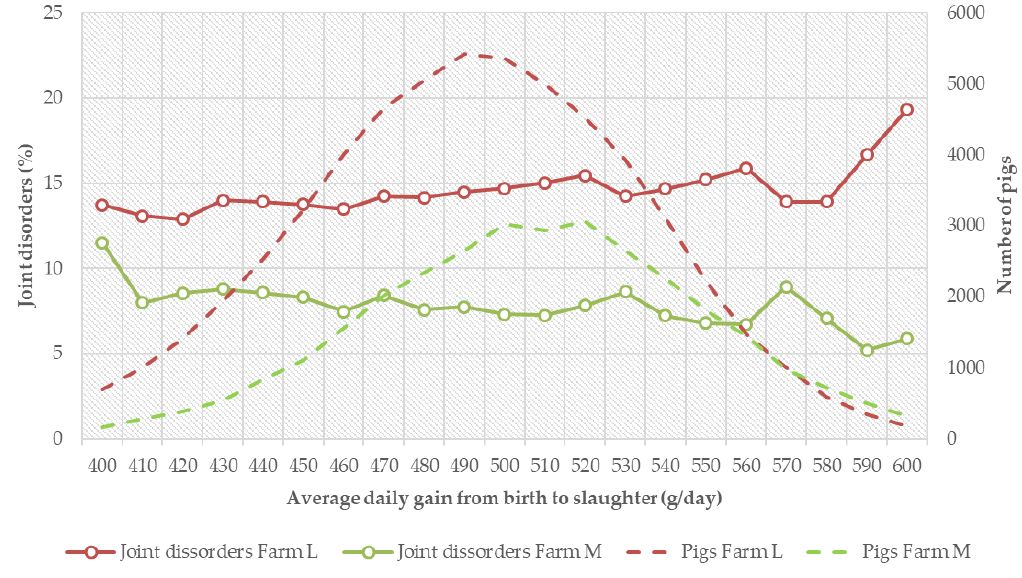
Figure 3. Relationship between growth from birth to slaughter in different classes and incidences of joint disorders (%) in two farms. The broken lines show distributions of pigs with respect to growth rate in the farms. Table 2. Variance component estimates and